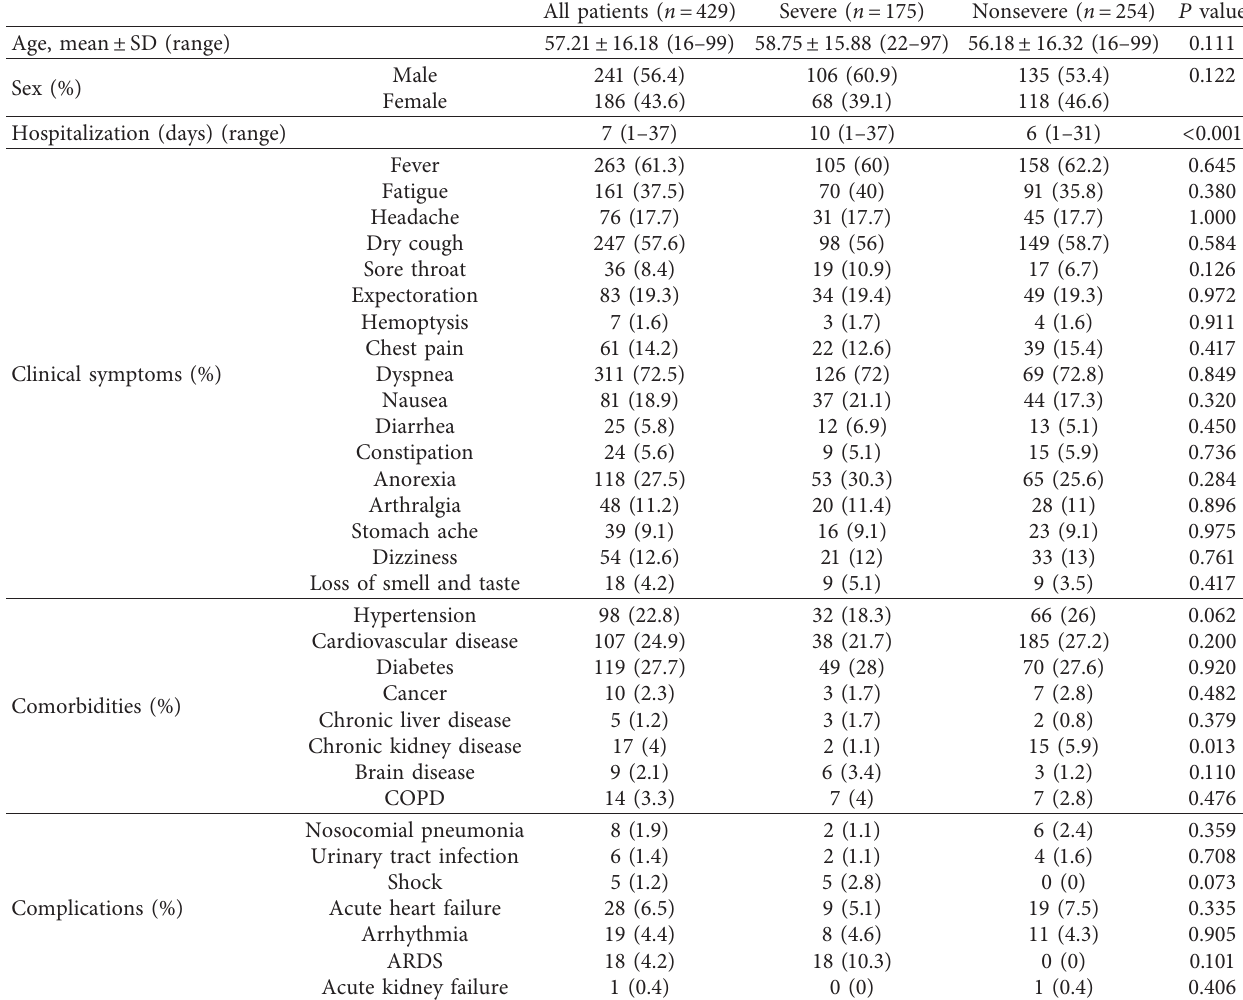
Table 1: Demographic and baseline characteristics of patients with